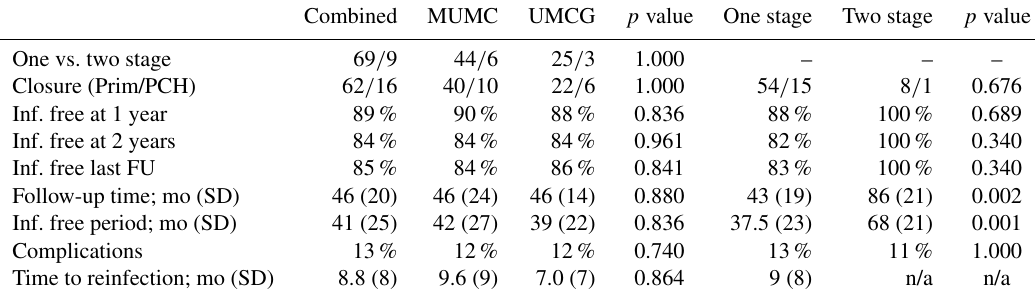
Table 4. Treatment/postoperative results.